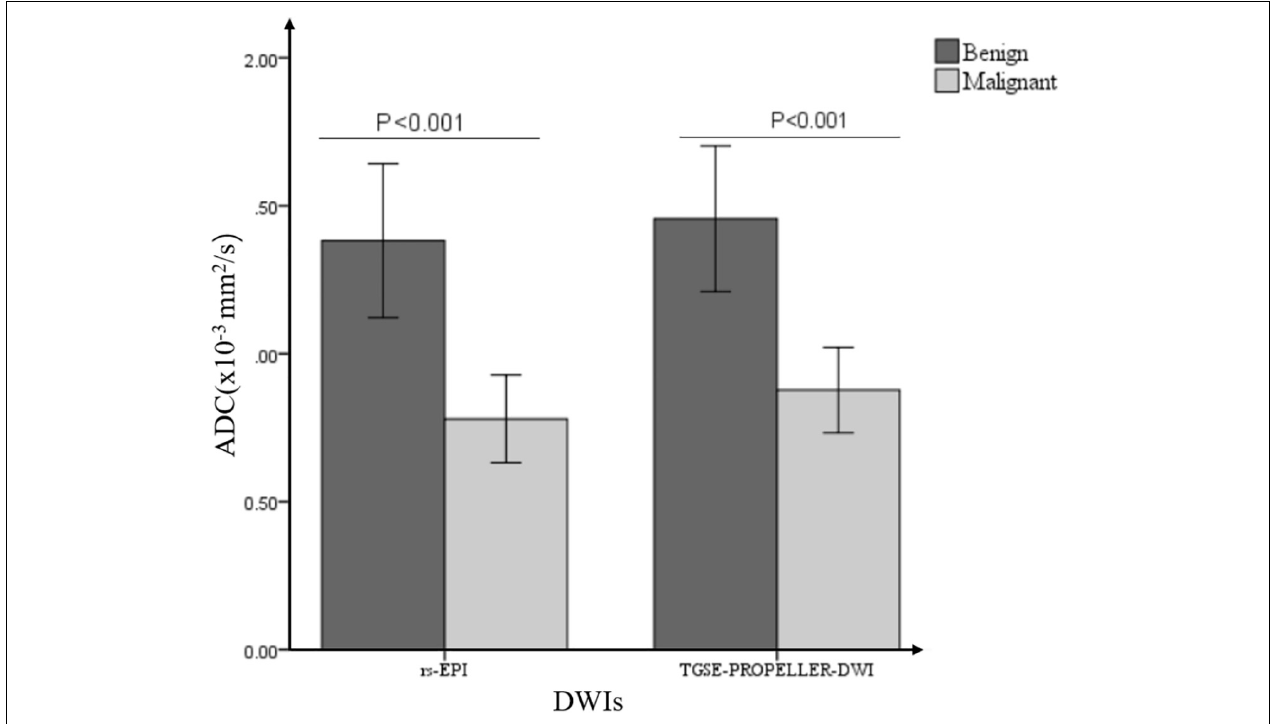
FIGURE 4 | Bar graph demonstrated the comparisons of ADC values between malignant and benign orbital tumors in two DWIs.